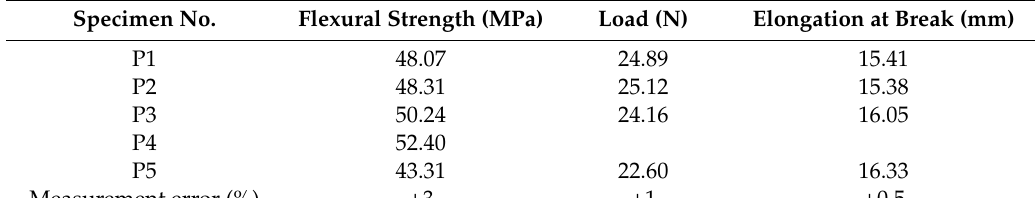
Table 8. Method 6 flexural test results for PUF-DCPD specimens. Specimen No.